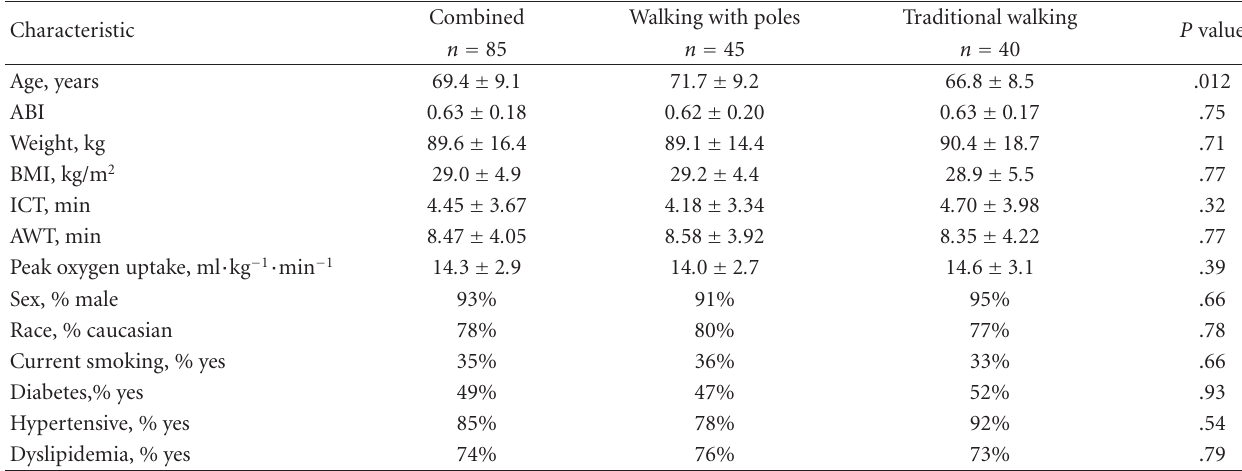
Table 1: Demographic characteristics of the